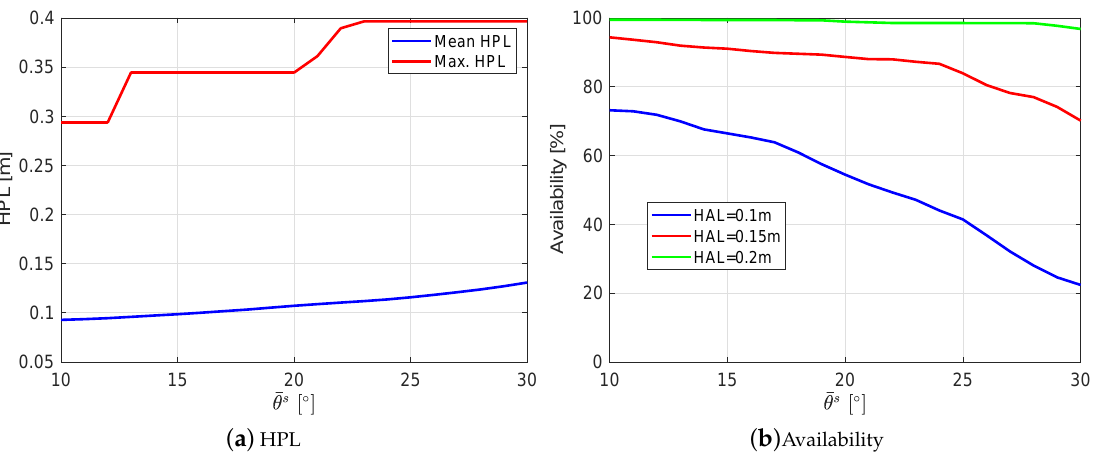
Figure 9. Change of ( a ) the mean and maximal HPLs and ( b ) the availabilities with the elevation threshold ¯ θ s for adding the phase bias term m c , k . The dataset in the suburban scenario during T1 is used for the